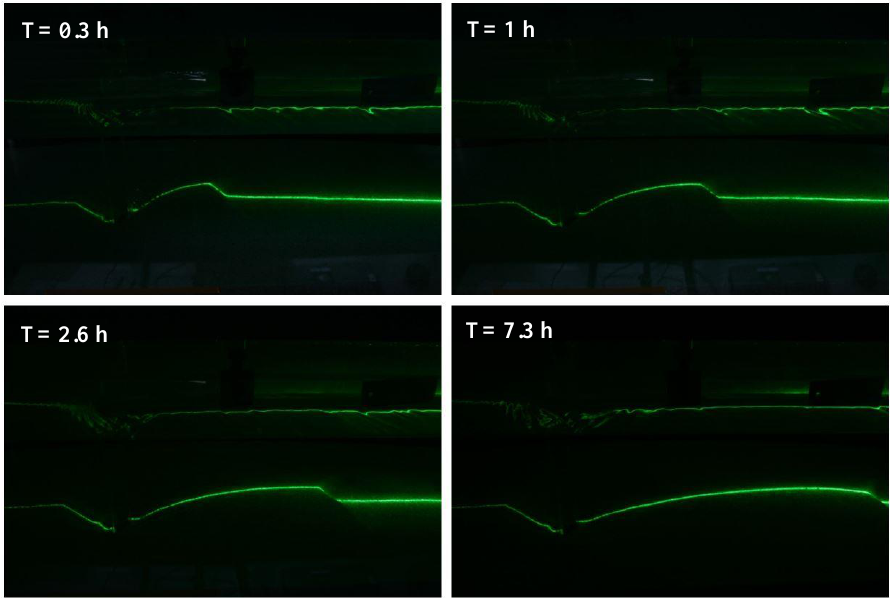
Figure 3. The profiles acquired by the camera during four moments in the experiment.